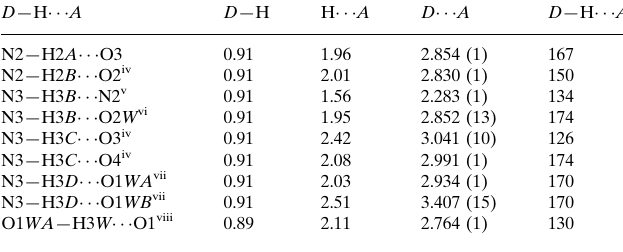
Hydrogen-bond geometry (A˚ , (cid:3)